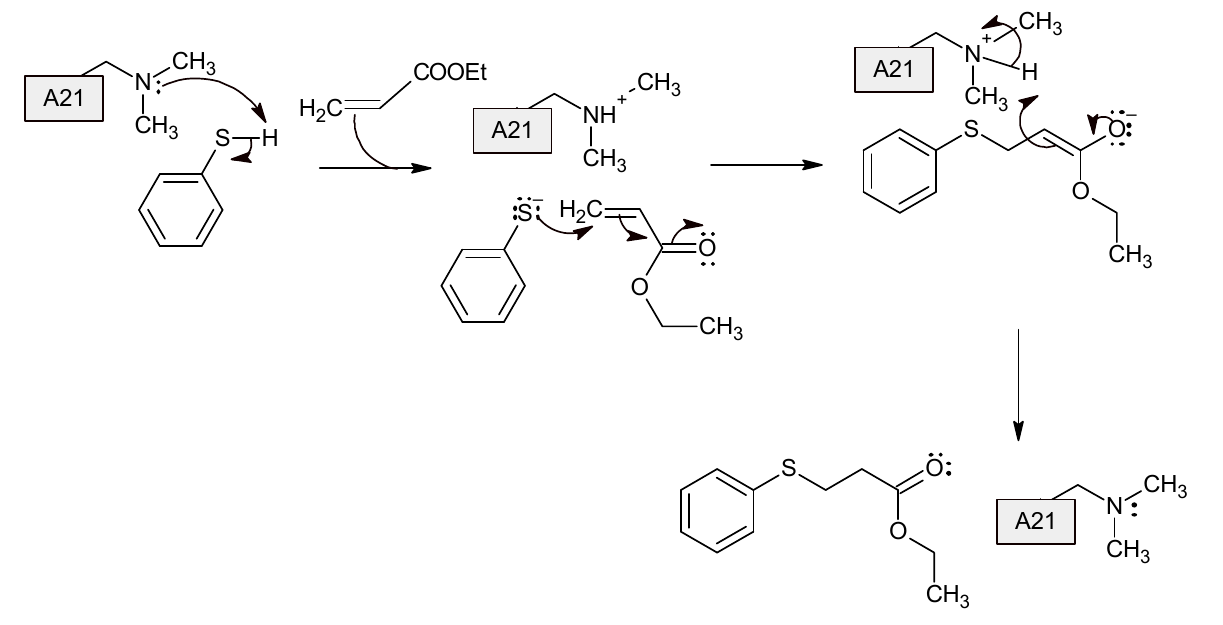
Table 2. Comparison of A21 catalyst and other reported catalysts in the synthesis of product 3a